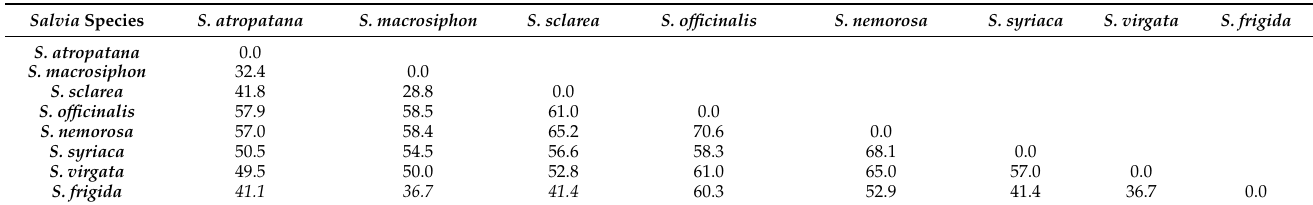
Table 4. Pairwise Euclidean distance based on chemical composition data.